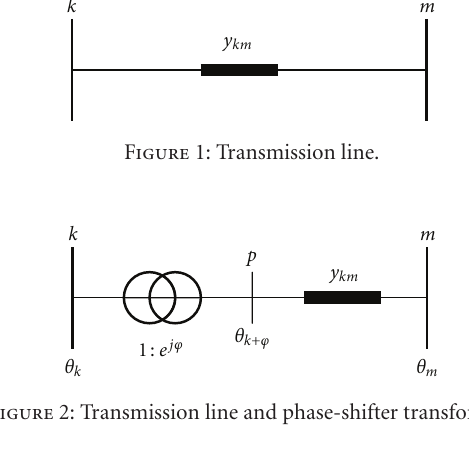
Figure 2: Transmission line and phase-shifter transformer.